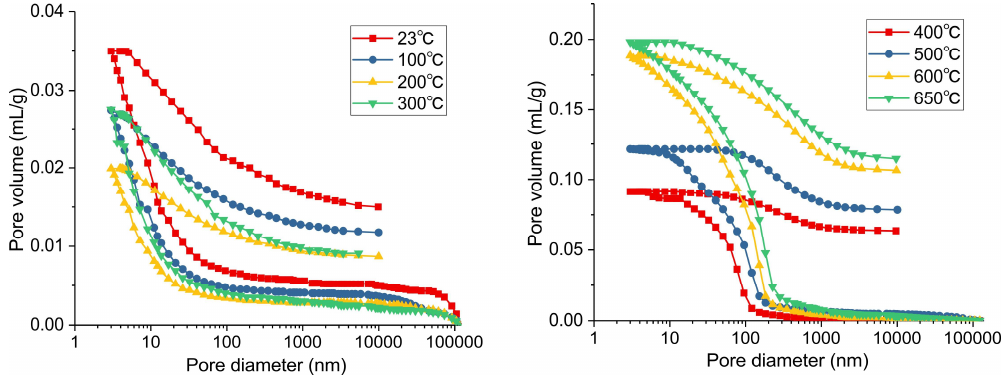
Figure 6. Pore volume versus pore diameter curves of mercury intrusion porosimetry (MIP) at different pyrolysis temperatures.